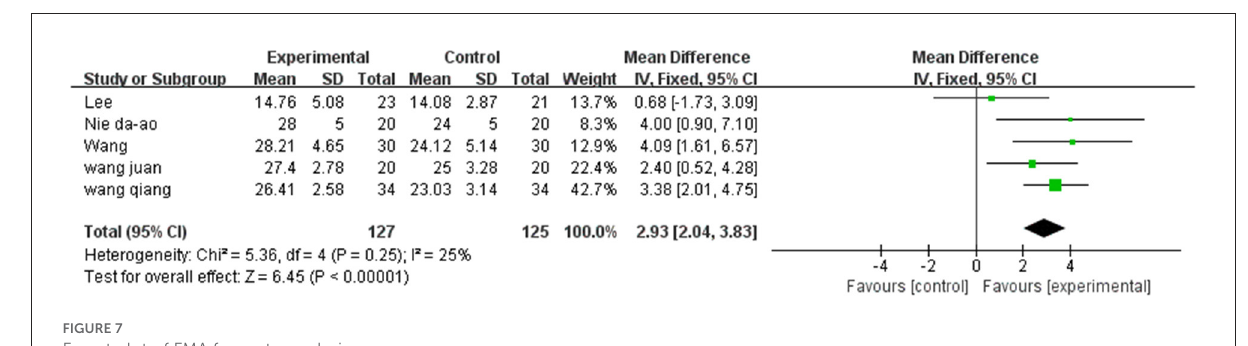
FIGURE7 Forest plot of FMA for